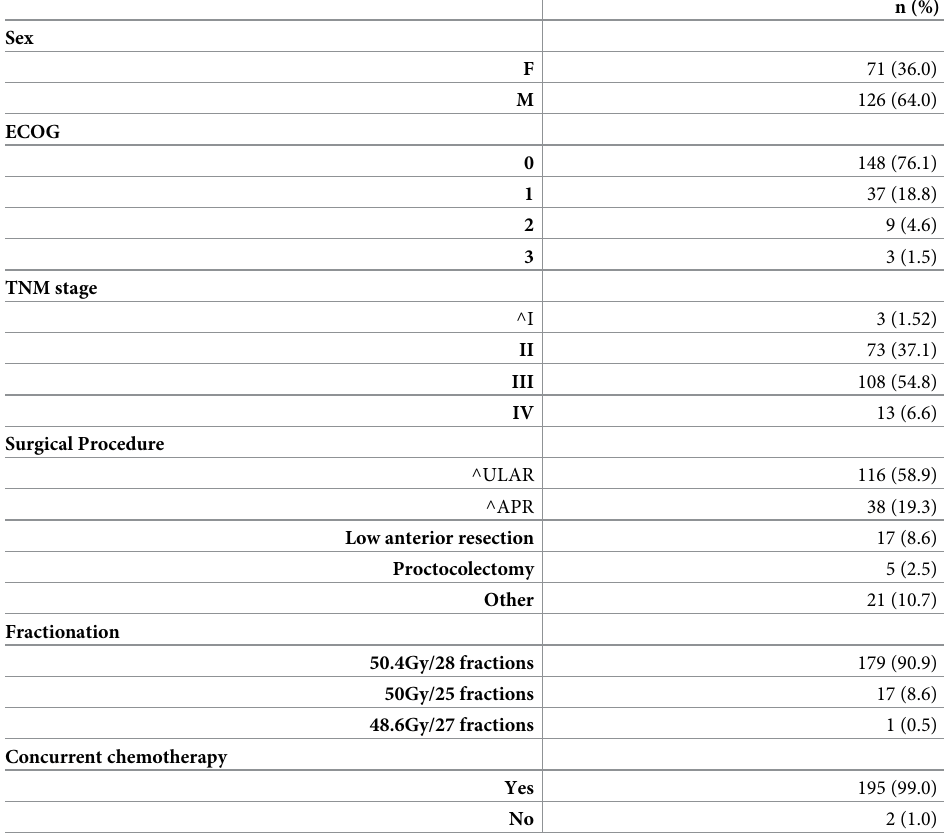
Table 1. Baseline clinicopathologic characteristics of 197 rectal adenocarcinoma